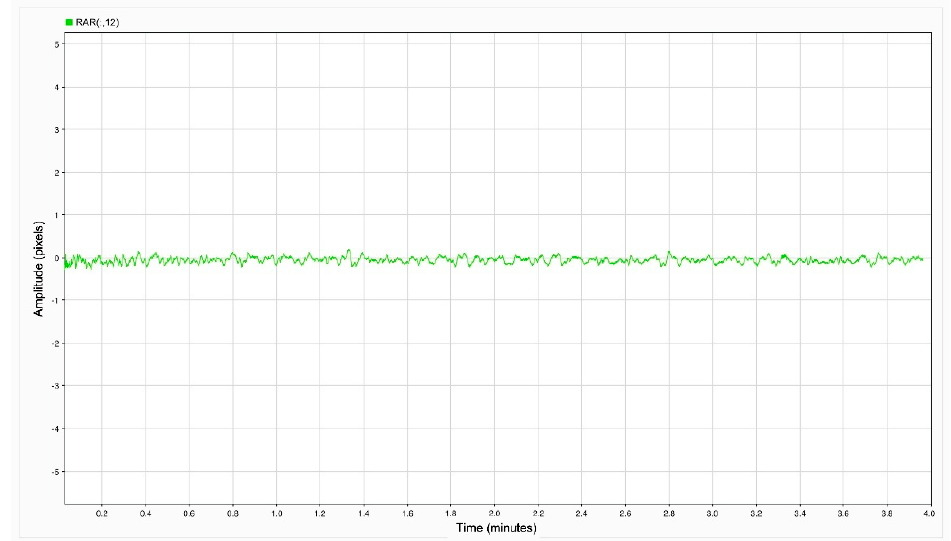
Figure 21. Amplitude chart of the TInRAR signal measured on the statue cheek. Unlike the behavior recorded for the gantry’s scanner support, the oscillation am- plitude was smaller of one order of magnitude. Figure 22 shows that from DIC analysis carried out on the statue, the 1.33 Hz frequency is not present, and no other predominant frequencies were detected.